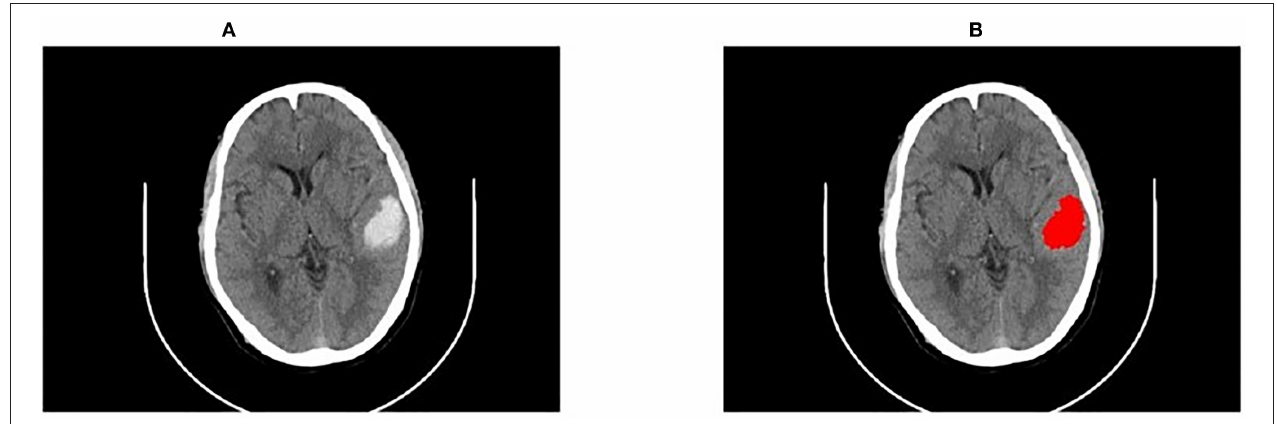
FIGURE 5 | An example of segmentation close to the skull. (A) The original CT image; (B) Restoration of the segmentation results.